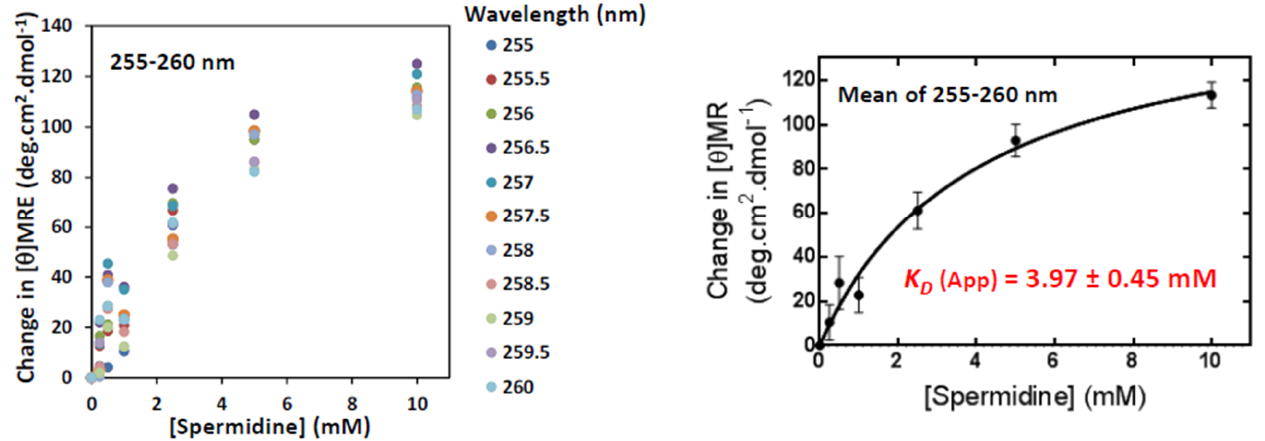
Figure 2. Quantification of spermidine binding to the A. baumannii efflux protein AceI by near-UV synchrotron radiation circular dichroism spectroscopy. From the spectra showing the titration of AceI(His 6 ) with spermidine (Figure 1, bottom right ), the change in mean residue ellipticity ([θ]MRE) at each titration point was measured at six different wavelengths in the region 255–260 nm ( left ). Average values for the change in [θ]MRE were fitted to the Michaelis–Menten equation using GraphPad Prism 6 software to produce the given apparent dissociation constant ( right ). Stability measurements confirmed that there was no significant change in spectra of the protein alone when continuously measured over a period of 12 h, which was longer than that of an entire titration with